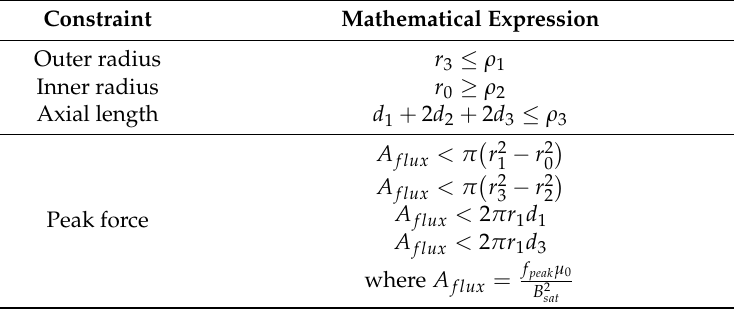
Table 1. Constraints present in axial magnetic actuator optimization